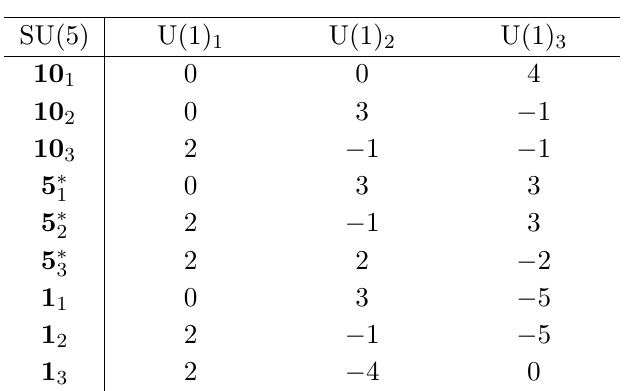
Table 1 . U(1) charges of the NG multiplets. The U(1) 1 , U(1) 2 and U(1) 3 are the unbroken U(1)’s of coset-subspaces E 7 /E 6 × U(1), E 6 /SO(10) × U(1) and SO(10)/SU(5) × U(1),